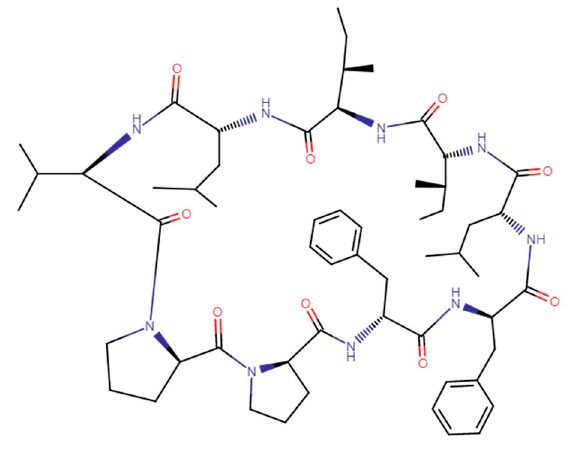
Figure 1. The structure of Cyclolinopeptide A (CAS